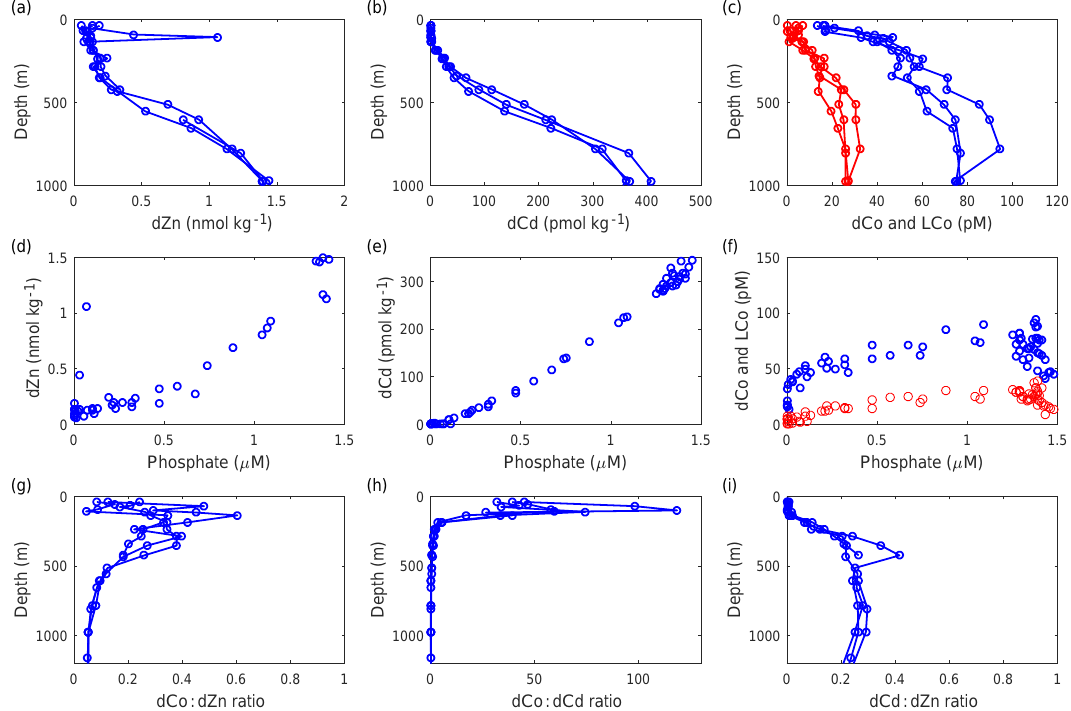
Figure 9. Zn, Cd, and Co and labile cobalt distributions (a–c) , relationships with phosphate (d–f) , and metal–metal ratios (g–i) in the central North Atlantic Subtropical Gyre at USGT-2011 stations 14, 16, and 18. Dissolved cobalt is in blue and labile cobalt is red in panels (c) and (f) . dZn and dCd were depleted at the base of the euphotic zone, resulting in dCo being ∼ 40% of the abundance of dZn and 1–2 orders of magnitude more abundant than dCd within the euphotic zone. dZn and dCd have concave relationships with phosphate, while dCo and LCo have convex relationships, implying faster biological drawdown of use of dZn and dCd relative to phosphorus, and vice versa for